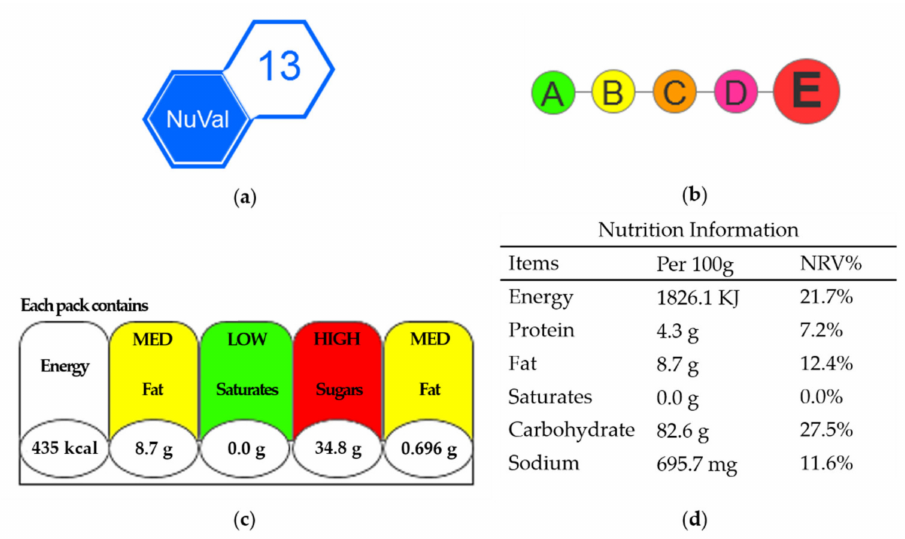
Figure 1. Nutrition labels. ( a ) The NuVal label; ( b ) the 5-color nutrition label (5-CNL); ( c ) the traffic light (TL) label; ( d ) the daily value (DV)